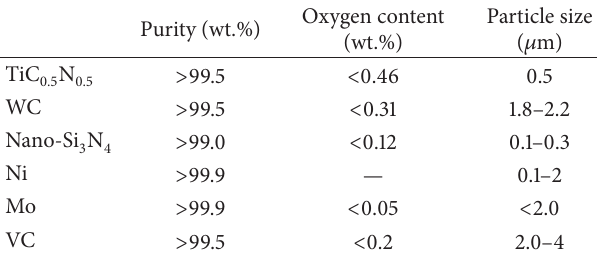
Table 1: Specifications of the initial powders used for the prepara- tion of TiCN-based cermets.